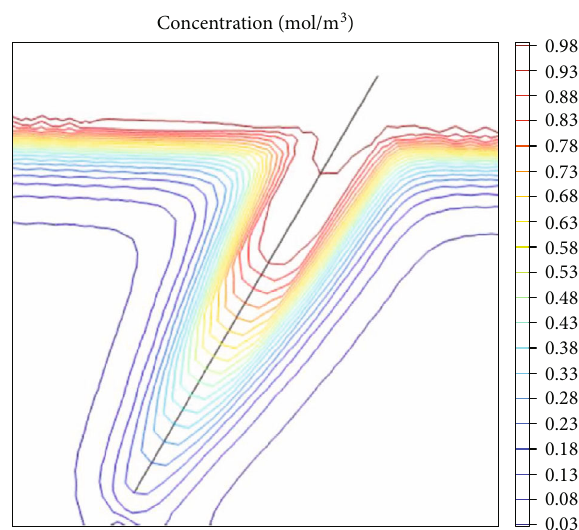
Figure 4: The concentration distribution contour of the MF